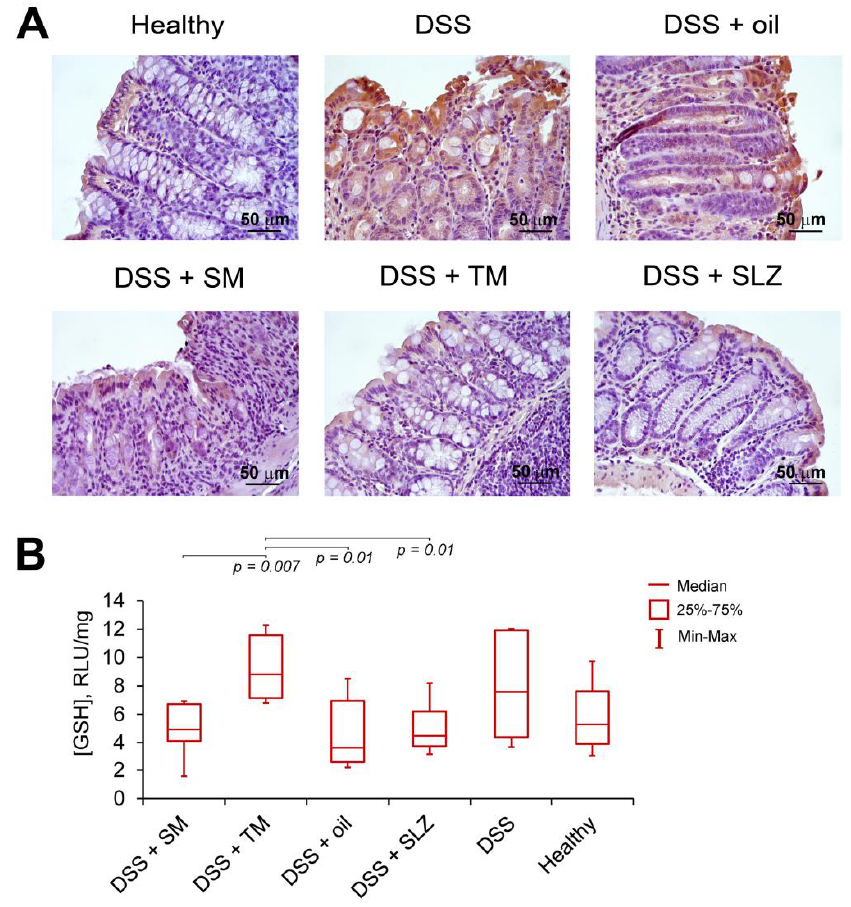
Figure 5. TM inhibited the production of the pro-inflammatory cytokine tumor necrosis factor α (TNF α ) and enhanced the antioxidant defense via glutathione (GSH) in DSS-induced colitis mice. ( A ) The e ff ect of SM and TM on TNF α production in colitis mice. Immunohistochemical staining with anti-TNF α monoclonal antibodies, magnification × 400. ( B ) The e ff ect of SM and TM on the GSH production in colitis mice. The data are presented as the means ± SD ( n = 7 per group).